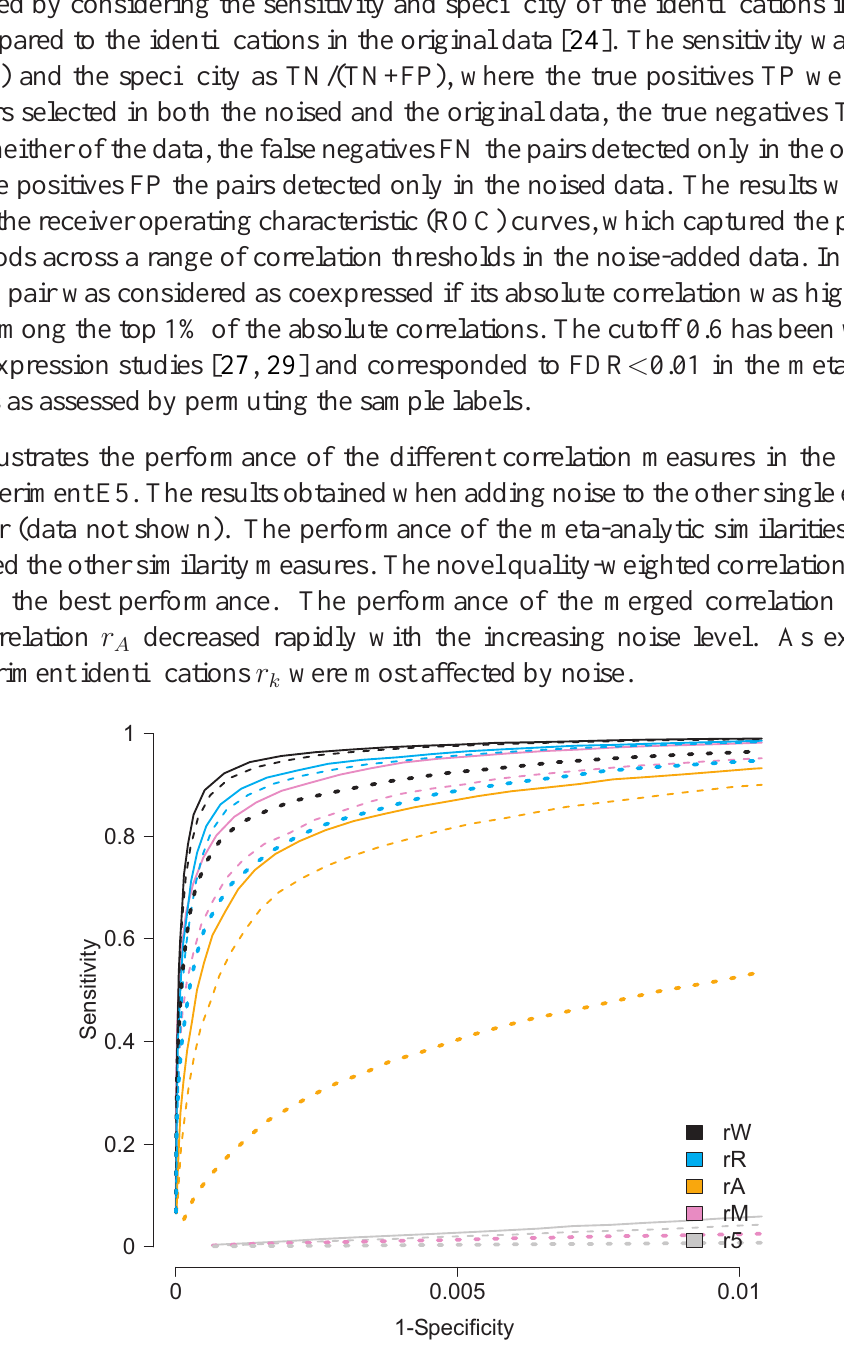
Figure 1: Performance of the different correlation measures when increasing levels of multiplica- tive Gaussian noise was added to the single experiment E5 (4 conditions). Average ROC curves over 10 datasets are shown at noise levels α = 0 . 01 (solid lines), α = 0 . 2 (dashed lines), and α = 0 . 5 (dotted lines). The standard deviations were negligible and were omitted for the clarity of illustration. When comparing the traces, the one closest to the upper left corner shows the best performance. The results are shown for the individual correlation in experiment E5 (r5), the merged correlation r M (rM), the average correlation r A (rA), the random effects meta-correlation r r R (rR), and the novel quality-weighted correlation W